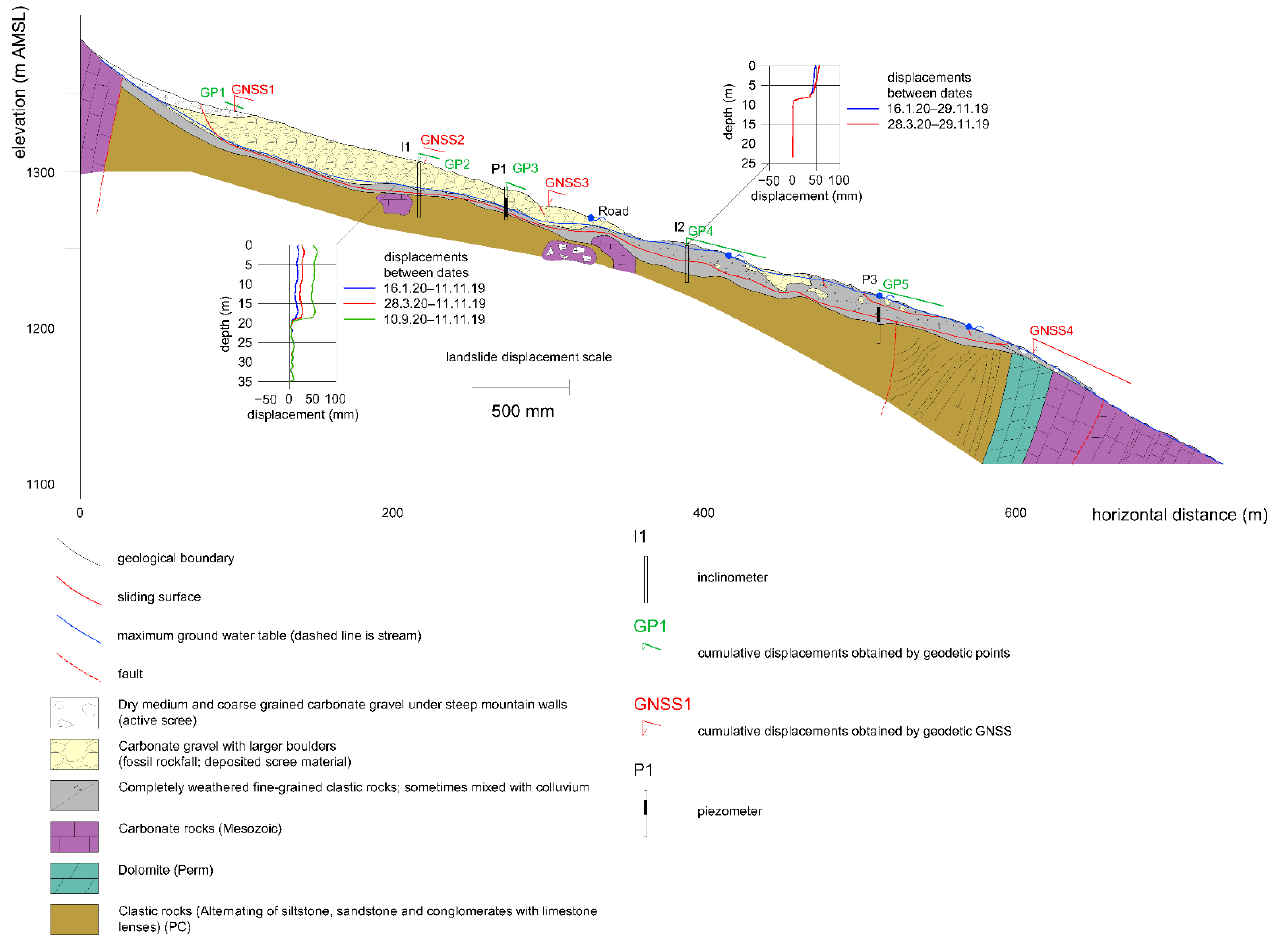
Figure 5. A cross-section along the Urbas landslide with data overview showing geological and hydrogeological settings, cumulative surface displacements obtained from GNSS, in situ object-point geodetic measurements, and deep displacements obtained by the inclinometer.